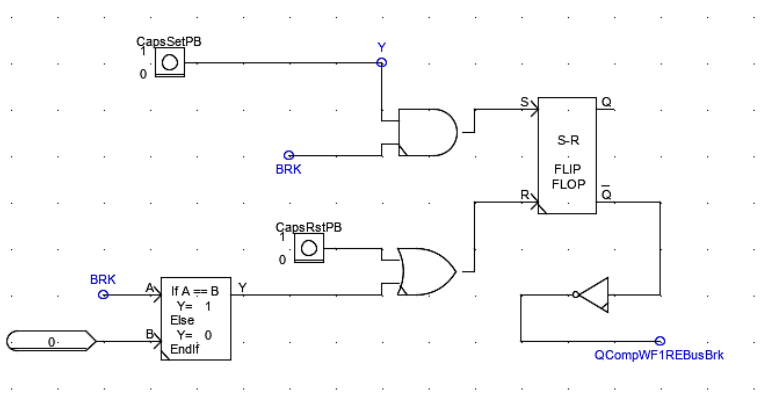
Figure 26. Monitoring and calculation logic for reactive power injection device switching logic.